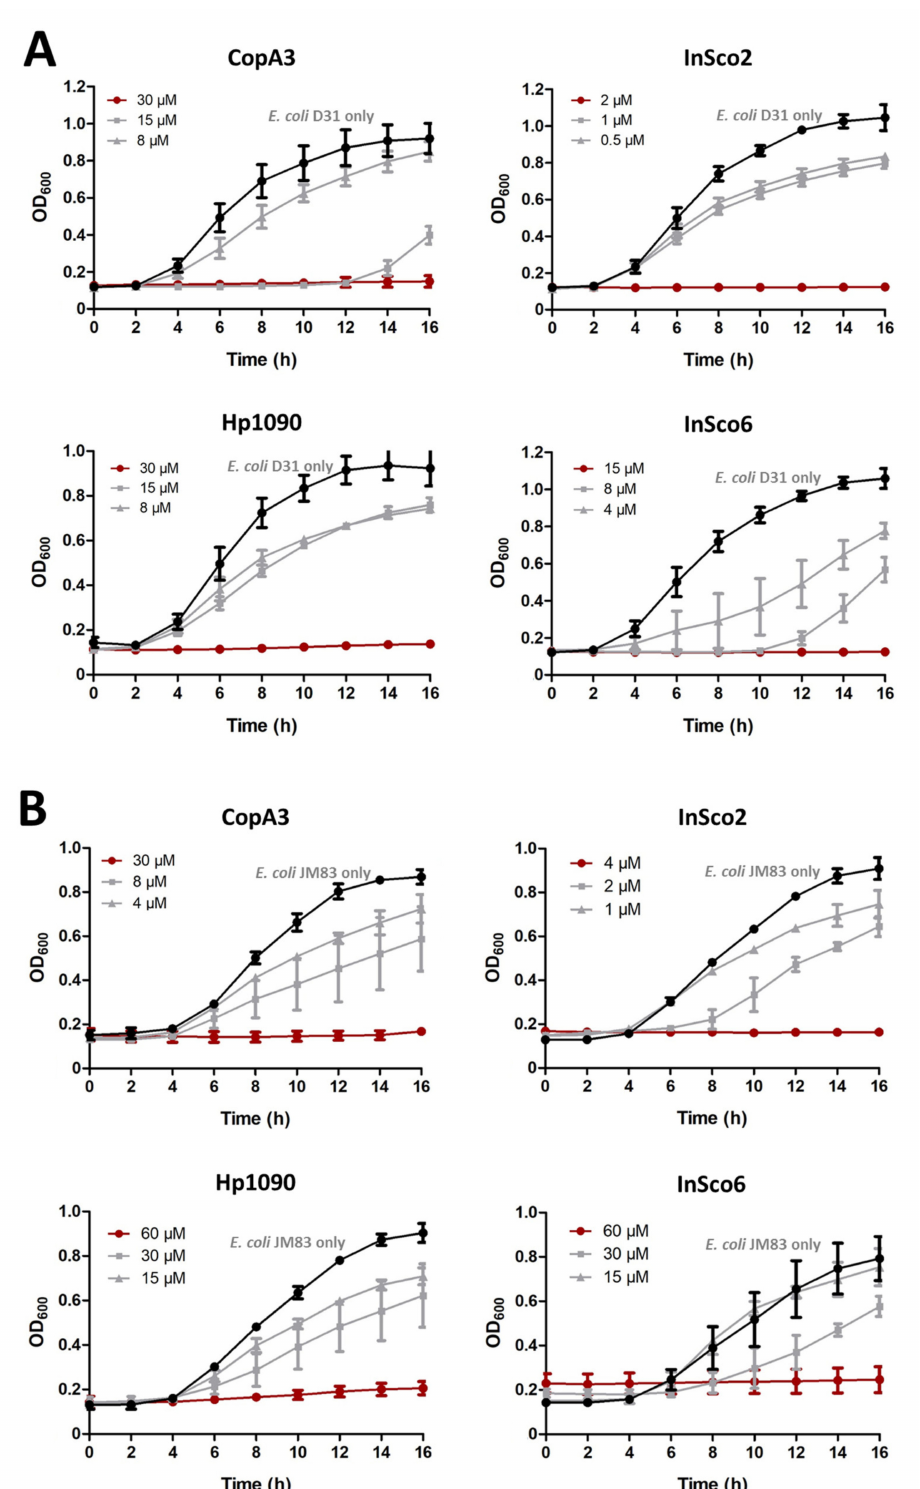
Figure 3. Antibacterial dose-response curves. The parental and hybrid peptides were tested against E. coli strains D31 ( A ) and JM83 ( B ) across the concentration range 0.015–250 µ M. Concentration-response curves were generated using decreasing peptide doses. The y -axis shows the optical density at 600 nm (OD 600 ) and the x -axis shows the assay time from 0 to 16 h. Each panel shows the total growth inhibition peptide concentrations (red line), different concentrations (gray lines) and the normal bacterial growth curve in the absence of AMPs (black